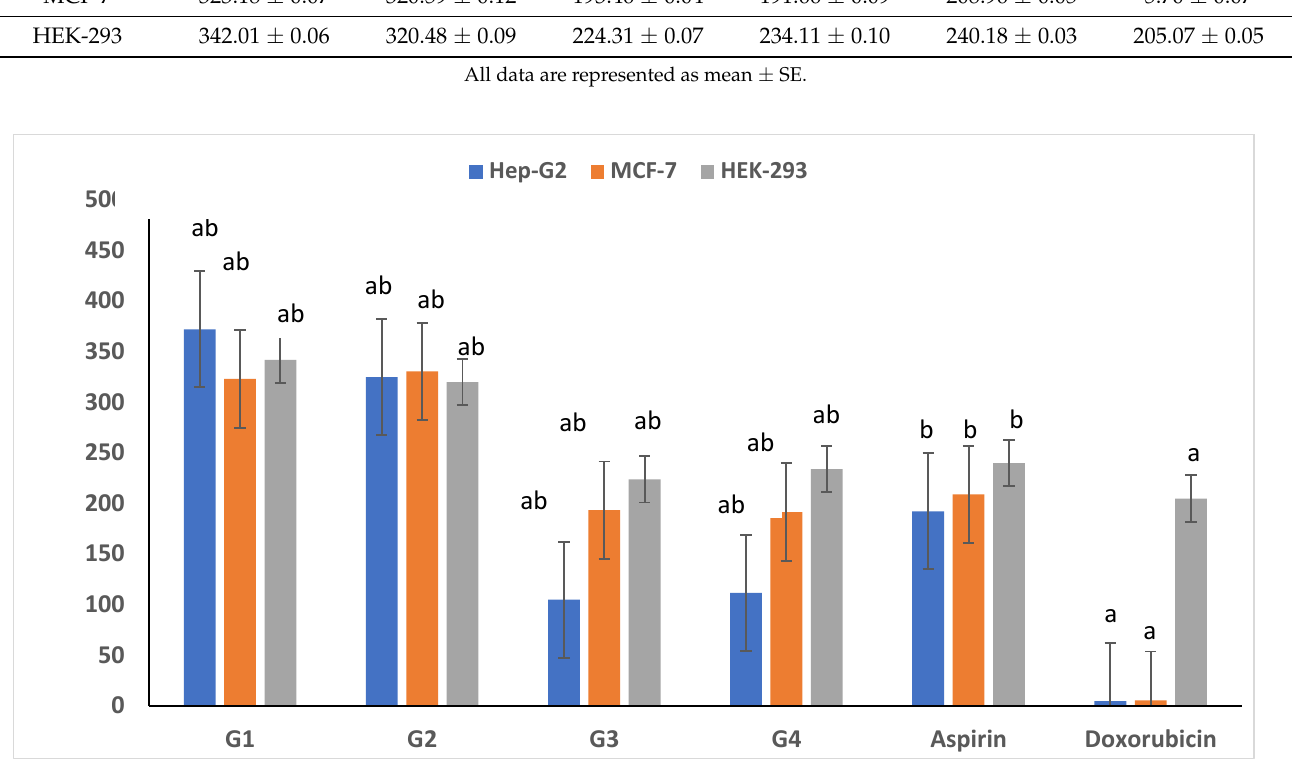
Figure 8. The results of cytotoxicity activity for the aspirin and G1-D3-Asp , G2-D6-Asp , G3-D9-Asp , and G4 - D12-Asp at 15 mg/mL against Hep-G2, MCF-7, and HEK-293 compared to doxorubicin. All data are represented as mean ± SE. Statistical significance was measured at p < 0.05 based on one-way analysis of variance ANOVA test followed by Tukey ’ s test for multiple comparisons. a significantly different from the aspirin group at p < 0.05, and b significantly different from the doxorubicin group at p < 0.05.